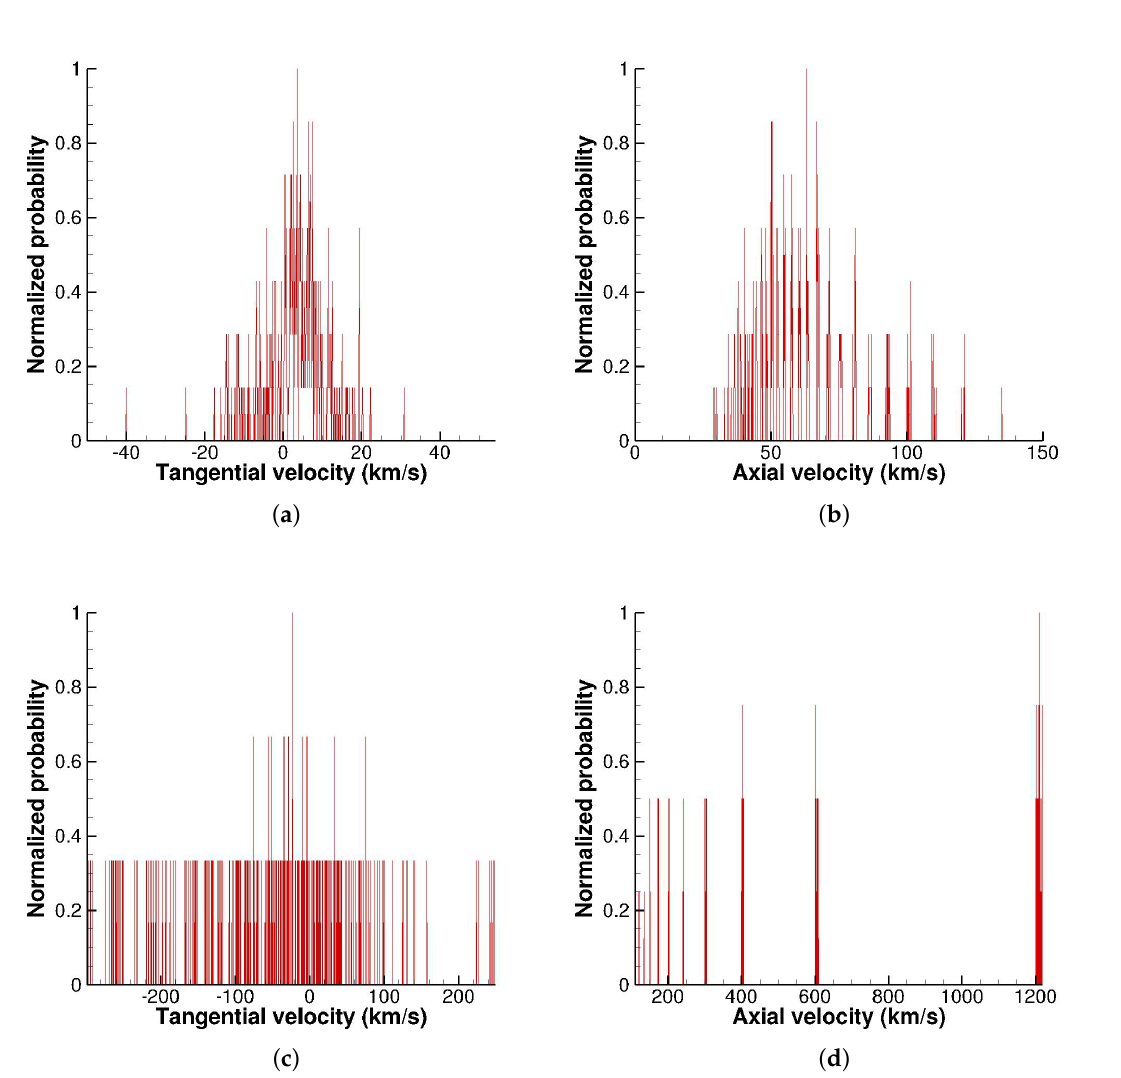
Figure 12. The tangential and axial velocity distributions of the monomers and droplets emitted from an EAN electrospray. The total number of droplets and monomers sampled is 390 and 321, respectively. ( a ) Tangential ( V x and V y ) velocities of droplets; ( b ) Axial ( V z , towards the extractor plane) velocities of droplets; ( c ) Tangential ( V x and V y ) velocities of monomers; ( d ) Axial ( V z , towards the extractor plane) velocities of